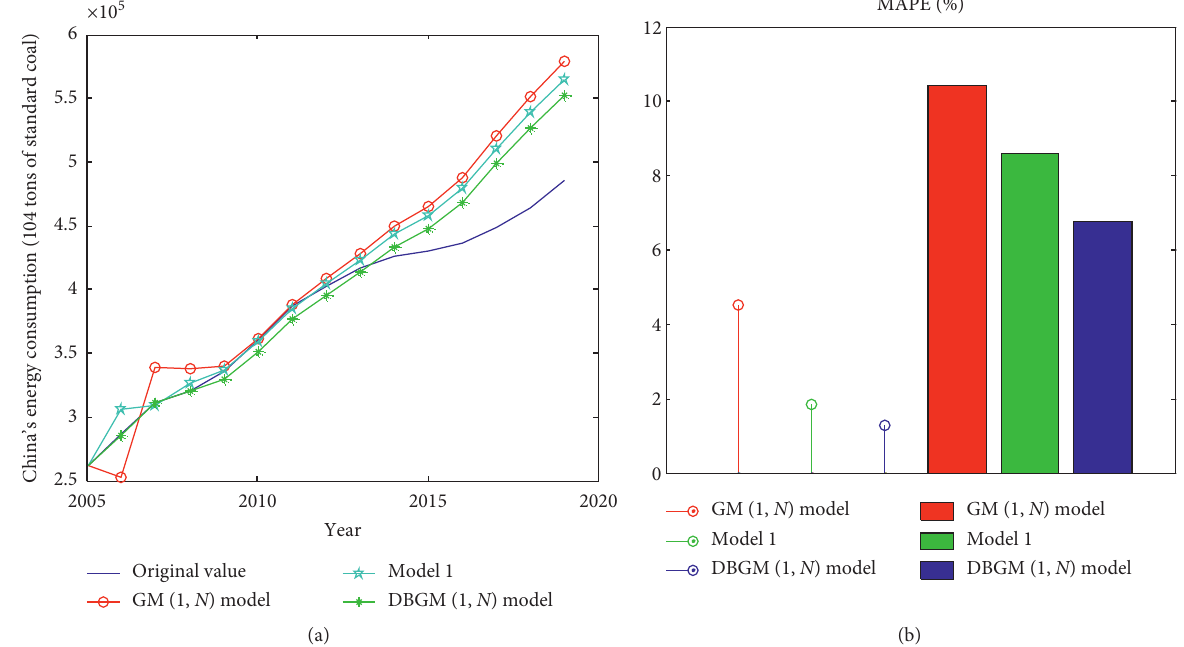
Figure 2: Schematic of the prediction results and MAPEs of the three prediction models (Case